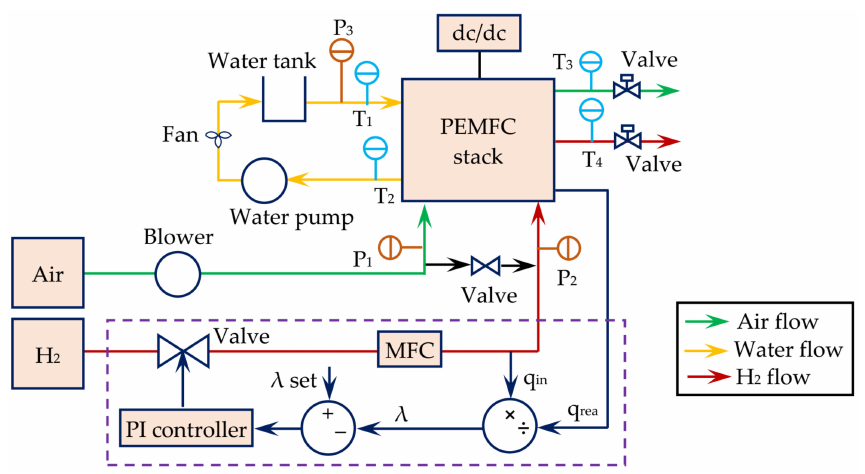
Figure 9. PEMFC system with air and fuel flow control